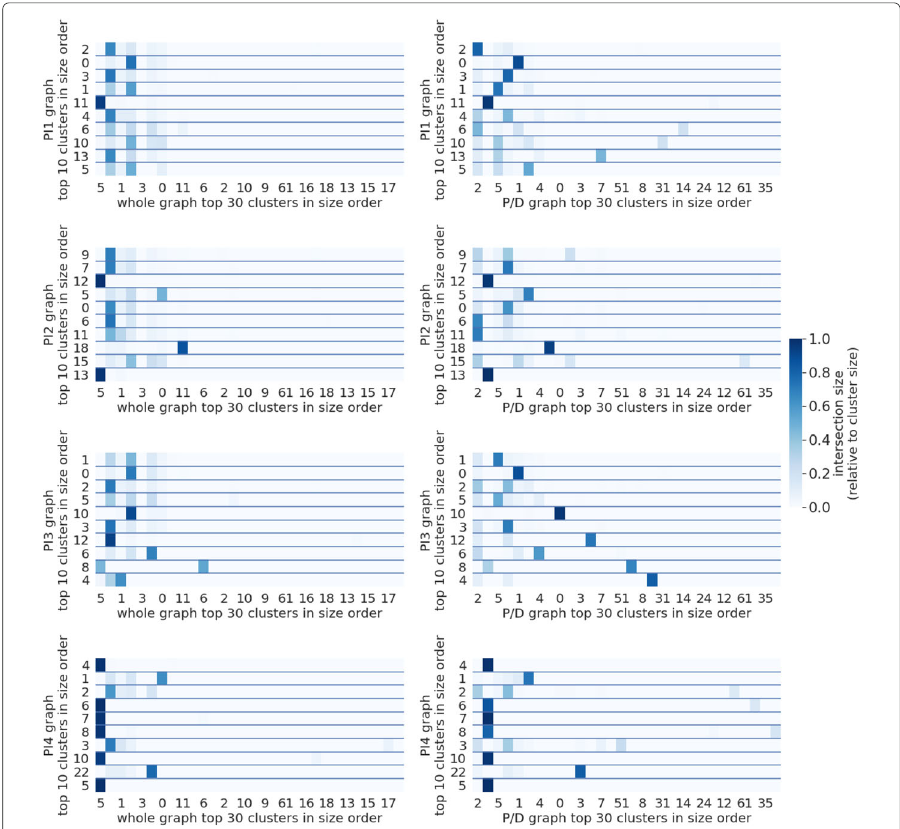
Fig. 7 Cluster-to-cluster intersection size: top 10 clusters of each PI graph vs. top 30 clusters of the whole retweet graph and the P/D graph clusters. The intersection size is normalized by the considered PI cluster size (i.e., each row is individually normalized and sums up to (almost)